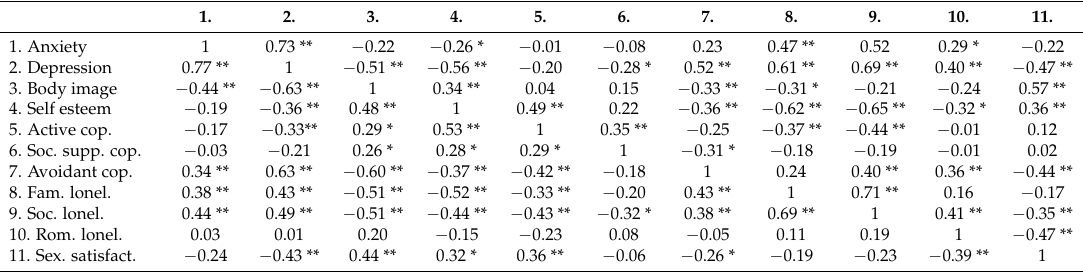
Table 3. Bivariate correlations for men and women separately (transgender men above the diagonal and transgender women below the